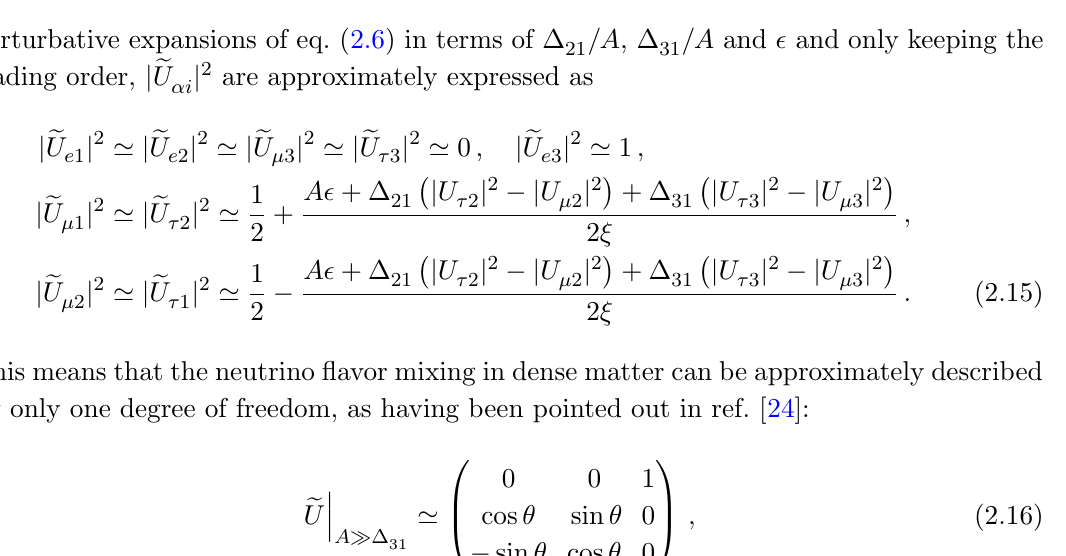
; (cid:18) ; (cid:18) ; (cid:14); (cid:1) ; (cid:1) ) in refs. [36, 37] 12 13 23 21 31